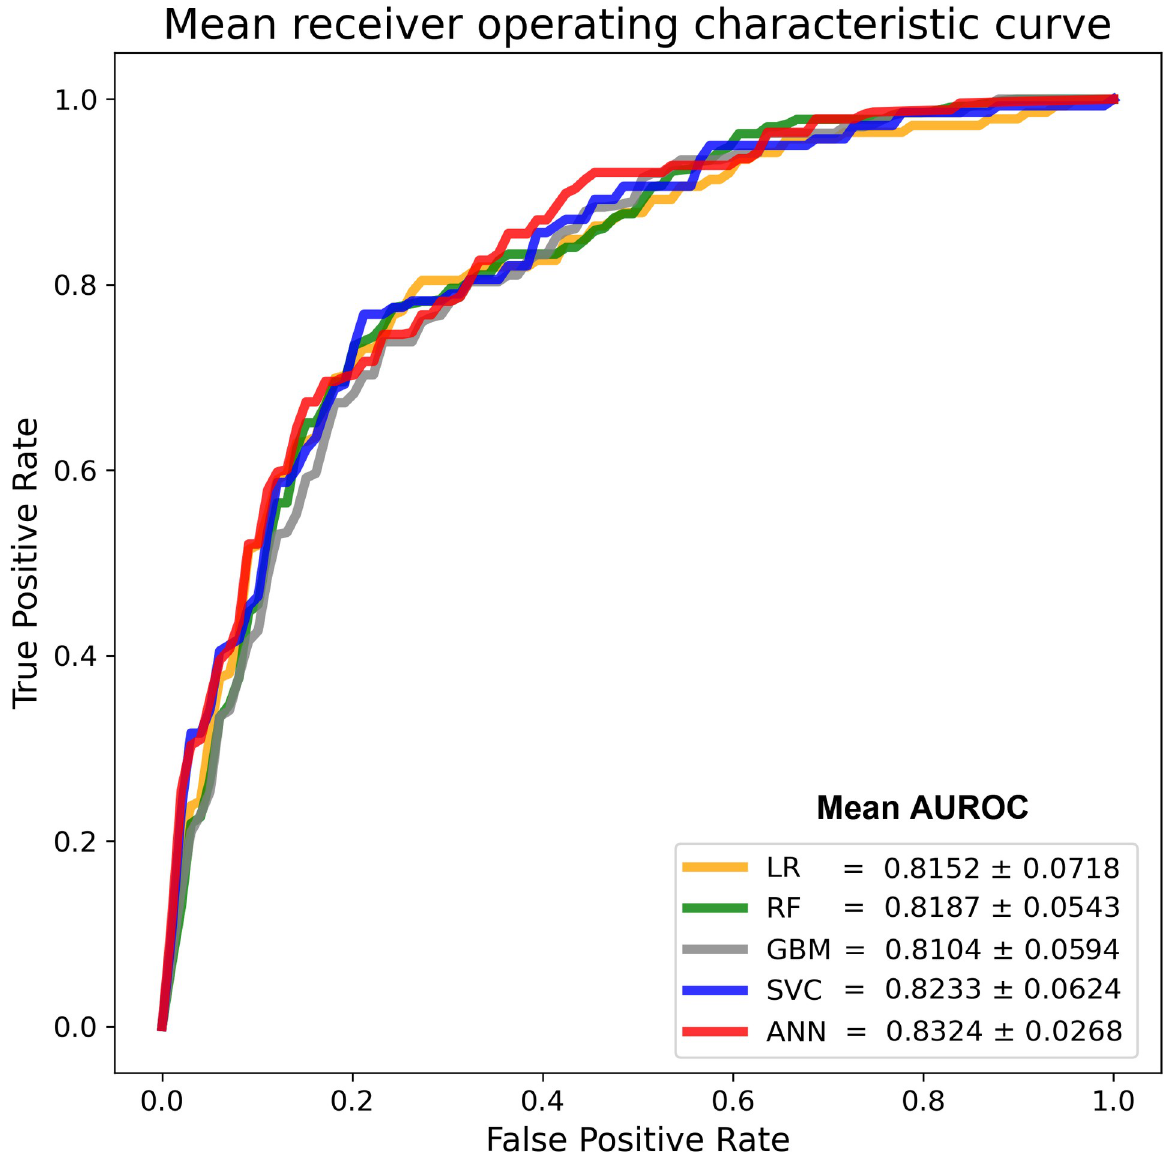
Fig 1. Comparing receiver operating characteristic curves of machine learning methods with 10-fold cross-validation. Mean receiver operating characteristic curves of prognostic models established using machine learning methods are displayed in the indicated